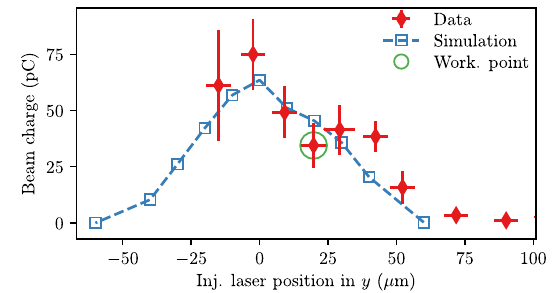
FIG. 5. Effect of centroid laser-spot positioning with respect to the electron beam. The laser position was measured on the upstream OTR camera while the charge was measured on the electron spectrometer screen (points with error bars). Results are compared to simulation results, shown as squares with the plasma profile modeled as shown in Fig. 1(e). The working point for the data presented in this paper is indicated by a green